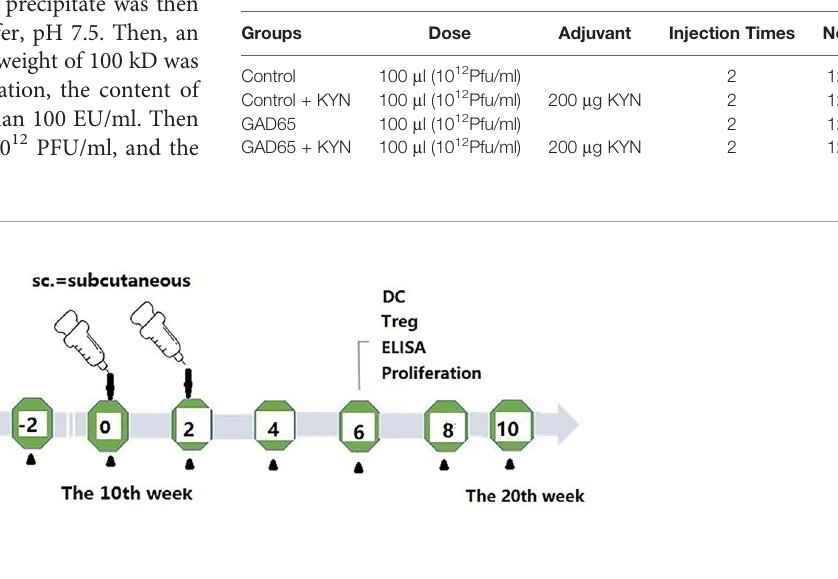
TABLE 1 | Animal groups and